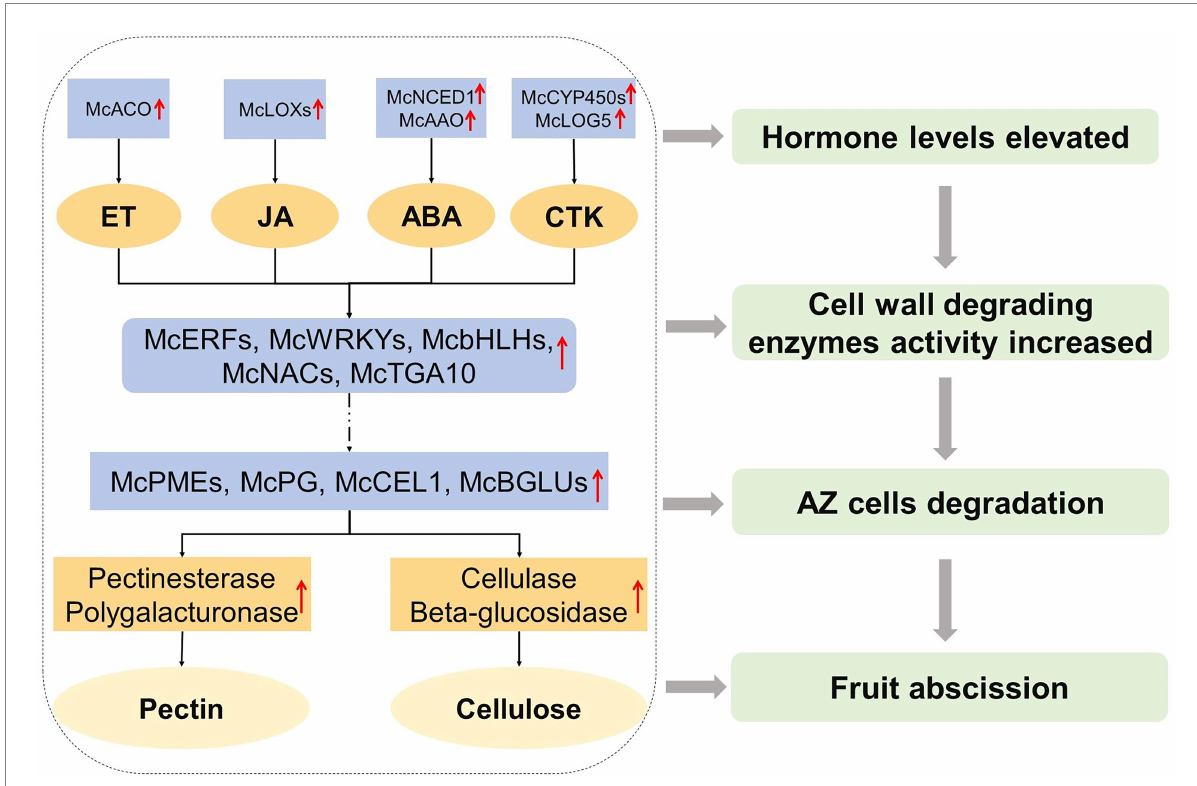
FIGURE 7 A model for regulating fruit abscission in ornamental crabapple was proposed. The expression of ethylene biosynthesis genes, jasmonic acid biosynthesis genes, abscisic acid biosynthesis genes, and cytokinin biosynthesis genes upregulated in AZ during fruit abscission. Cell wall hydrolase-related genes were also upregulated. Solid arrows indicate known mechanisms; broken arrows indicate unknown mechanisms, and red represents upregulation increase